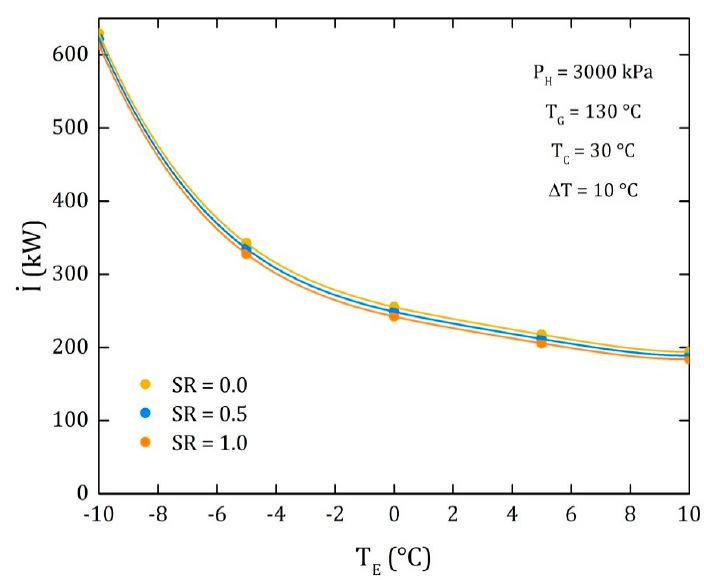
Figure 12. Irreversibilities as a function of T E for Model III at three different values of SR.